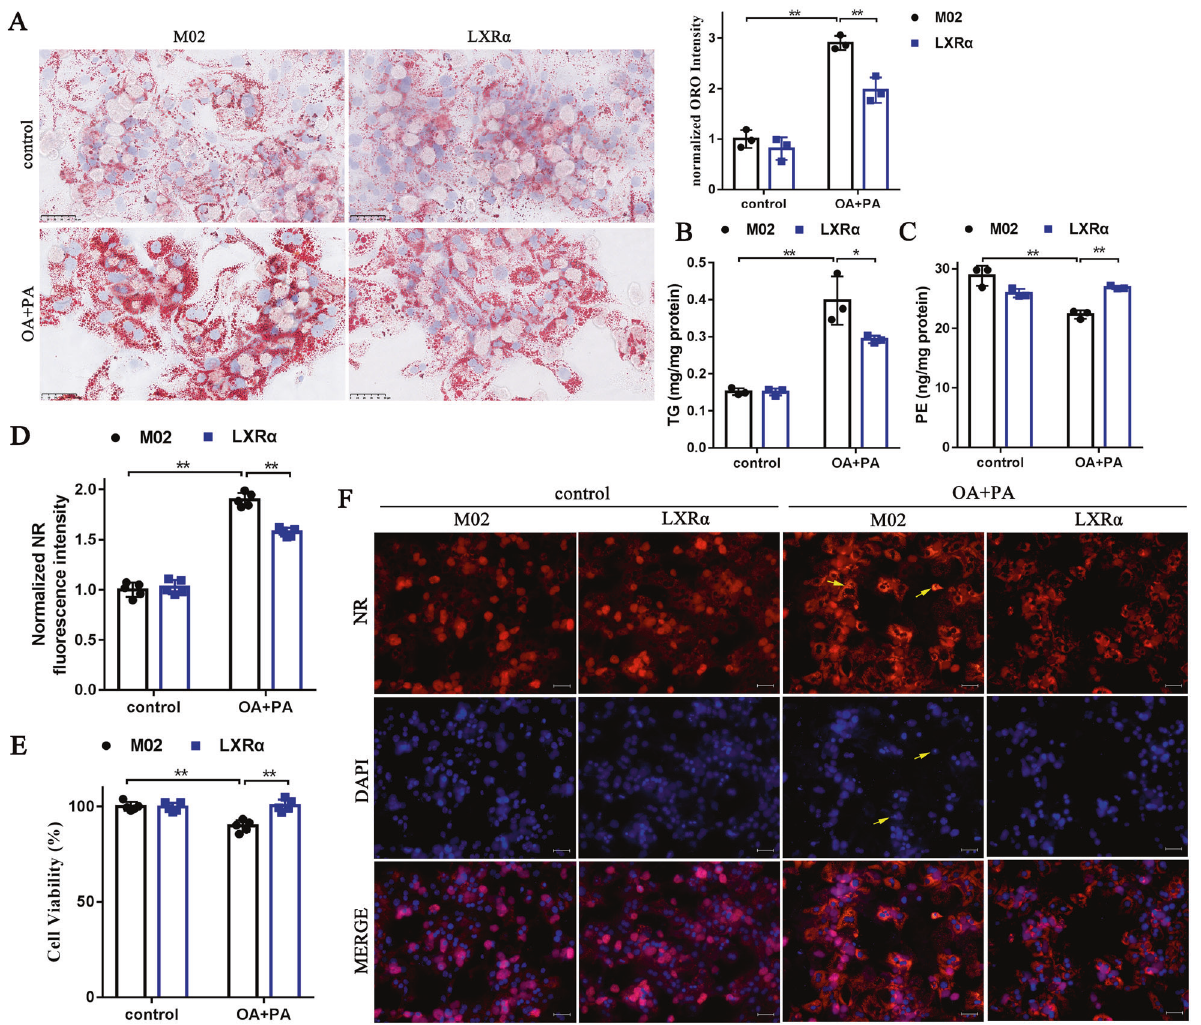
Fig. 9 Restoration of LXR α function alleviates the deleterious effects of LXR α ablation on primary hepatocyte. A Oil red O staining of primary hepatocyte from LXR α − / − mice in response to control reagent or OA + PA after transfection with M02 or LXR α expression plasmid. Scale bar, 50 μ m. Data are mean ± SD ( n = 3). * P < 0.05; ** P < 0.01. B , C TG and PE contents in hepatocyte from LXR α − / − mice in response to control reagent or OA + PA after transfection with M02 or LXR α expression plasmid. Data are mean ± SD ( n = 3). * P < 0.05; ** P <